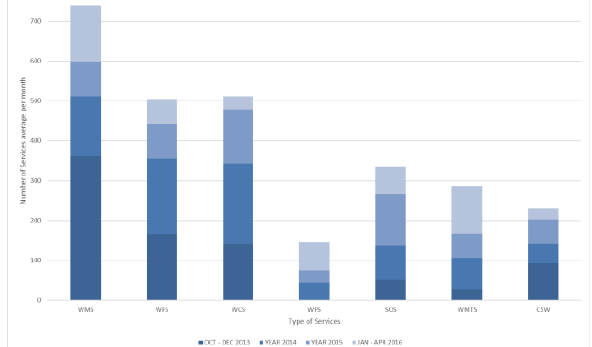
Figure 4. Number of URLs discovered within individual years for OGC services